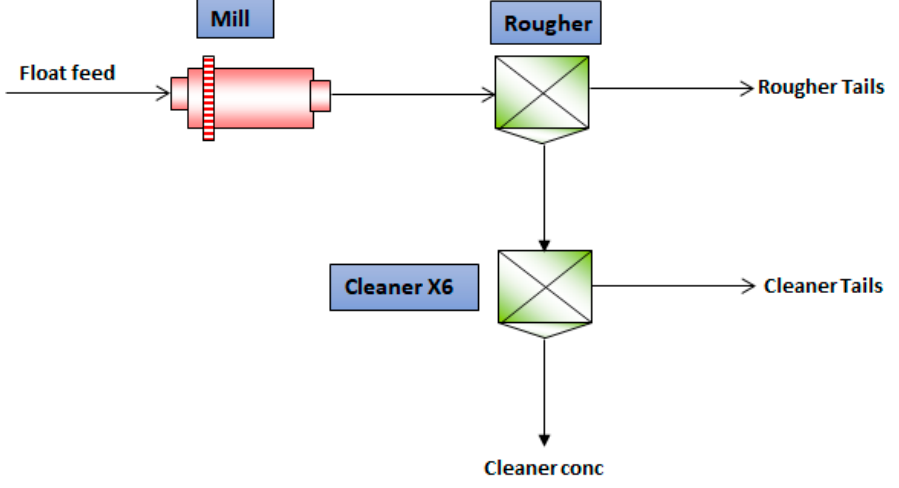
Figure 2. Flowsheet for the processing of ore A.